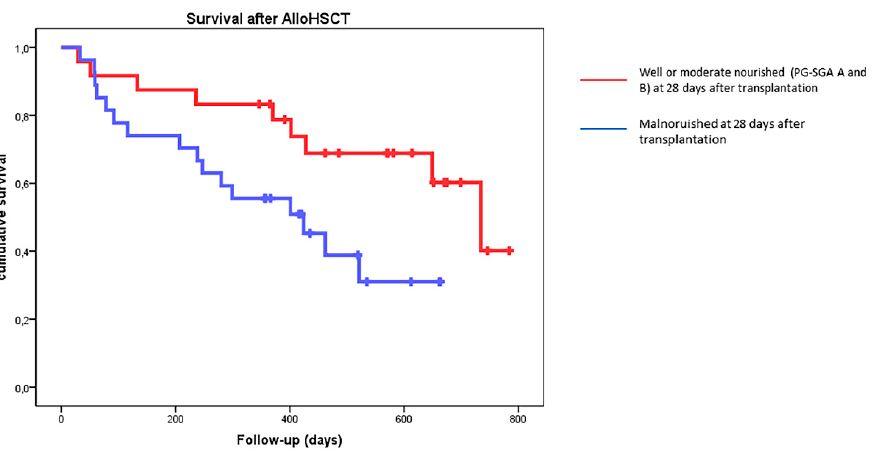
Figure 3. Estimated overall survival (OS) of the whole population according to PG-SGA status at 28 days after transplantation. p = 0.03.